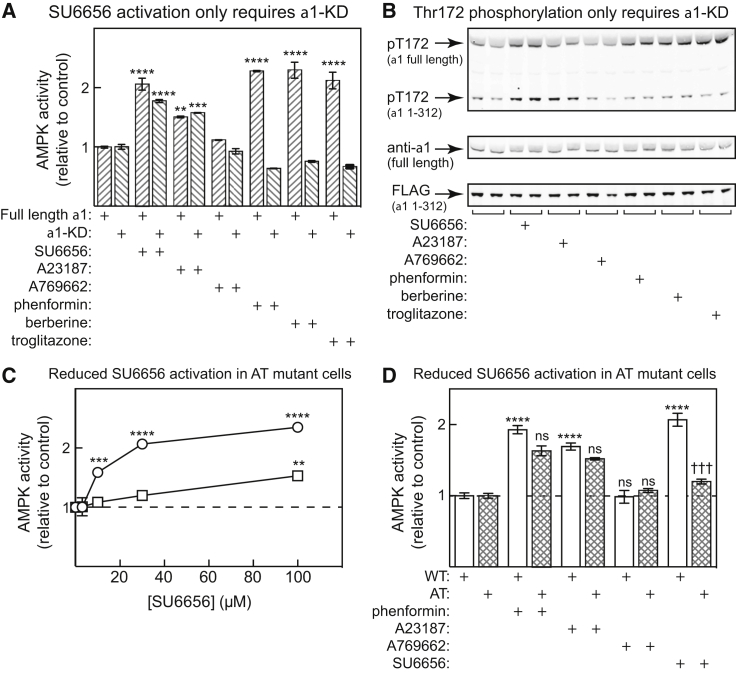
SU6656 Promotes AMPK Activation by Binding to the Catalytic Site: Studies in Intact Cells(A) FLAG-tagged α1 kinase domain (α1-KD, 1–312) was expressed by transient transfection in HEK293 cells and the cells treated with SU6656 (100 μM), A23817 (10 μM), A769662 (300 μM), phenformin (10 mM), berberine (100 μM), or troglitazone (100 μM) for 1 hr. The α1-KD was precipitated using anti-FLAG and endogenous AMPK complexes using anti-α1 antibody, and activity determined. Results (mean ± SD, n = 2) are expressed relative to activities in DMSO controls.(B) Western blots (n = 2) using the indicated antibodies; samples from experiment in (A).(C) DNAs encoding FLAG-tagged AMPK-α1 (WT or AT mutant) were expressed by transient transfection in HEK293 cells, the cells treated with increasing concentrations of SU6656 for 1 hr, AMPK complexes precipitated with anti-FLAG, and activity measured. Results (mean ± SD, n = 3) are expressed relative to the DMSO control. The absolute activities of the WT and AT mutant were 0.14 ± 0.01 (WT) and 0.12 ± 0.01 nmol/min/mg (mean ± SEM, n = 3); in separate experiments we showed that the AT mutant was stimulated 2.6-fold by 200 μM AMP, similar to the WT.(D) As (C), but cells were treated with phenformin (10 mM), A23187 (10 μM), A769662 (300 μM), or SU6656 (100 μM) for 1 hr. Results (mean ± SD, n = 3) are expressed relative to the DMSO control.**p < 0.01, ***p < 0.001, ****p < 0.0001, †††p < 0.001; ns, not significant.